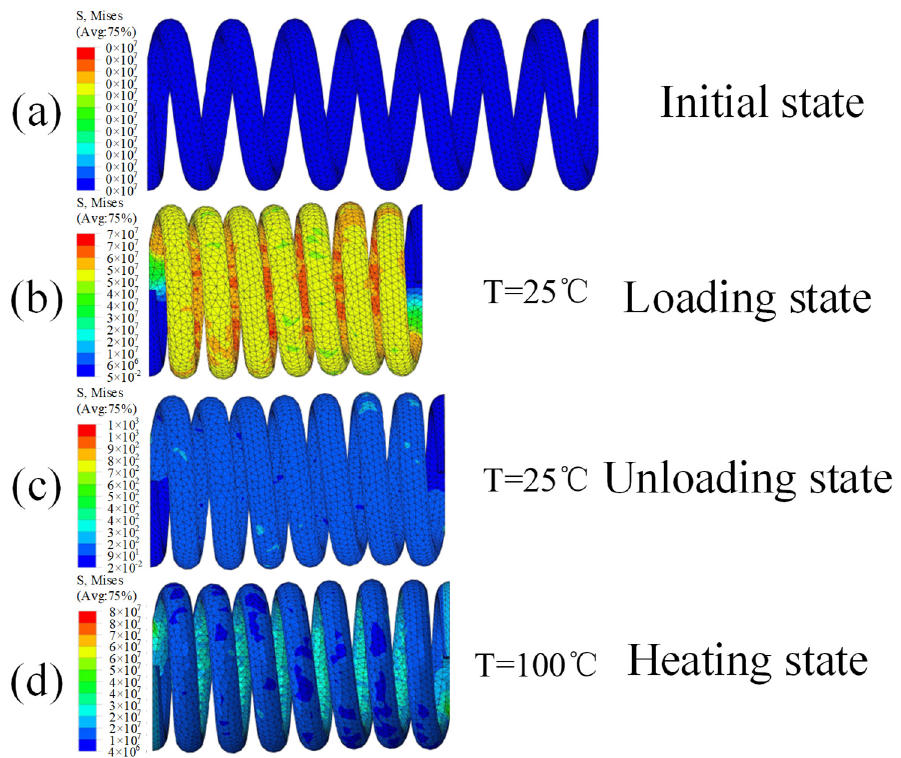
Figure 5. SMA stress distribution plots for each state. ( a ) Initial state of spring; ( b ) Loading state of spring; ( c ) Unloading state of spring; ( d ) Heating state of spring. spring; ( c ) Unloading state of spring; ( d ) Heating state of